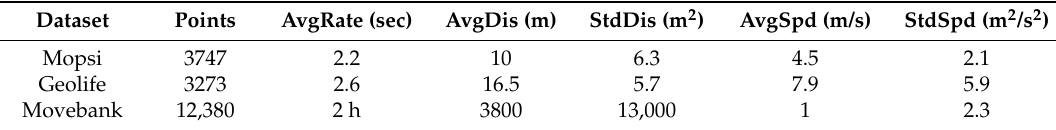
Table 2. Statistics of three example trajectories.